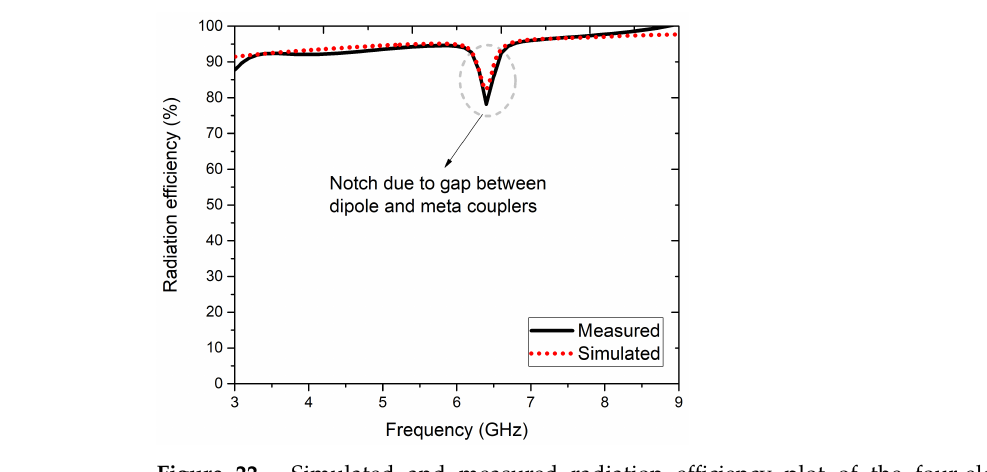
Figure 22. Simulated and measured radiation efficiency plot of the four-element antenna